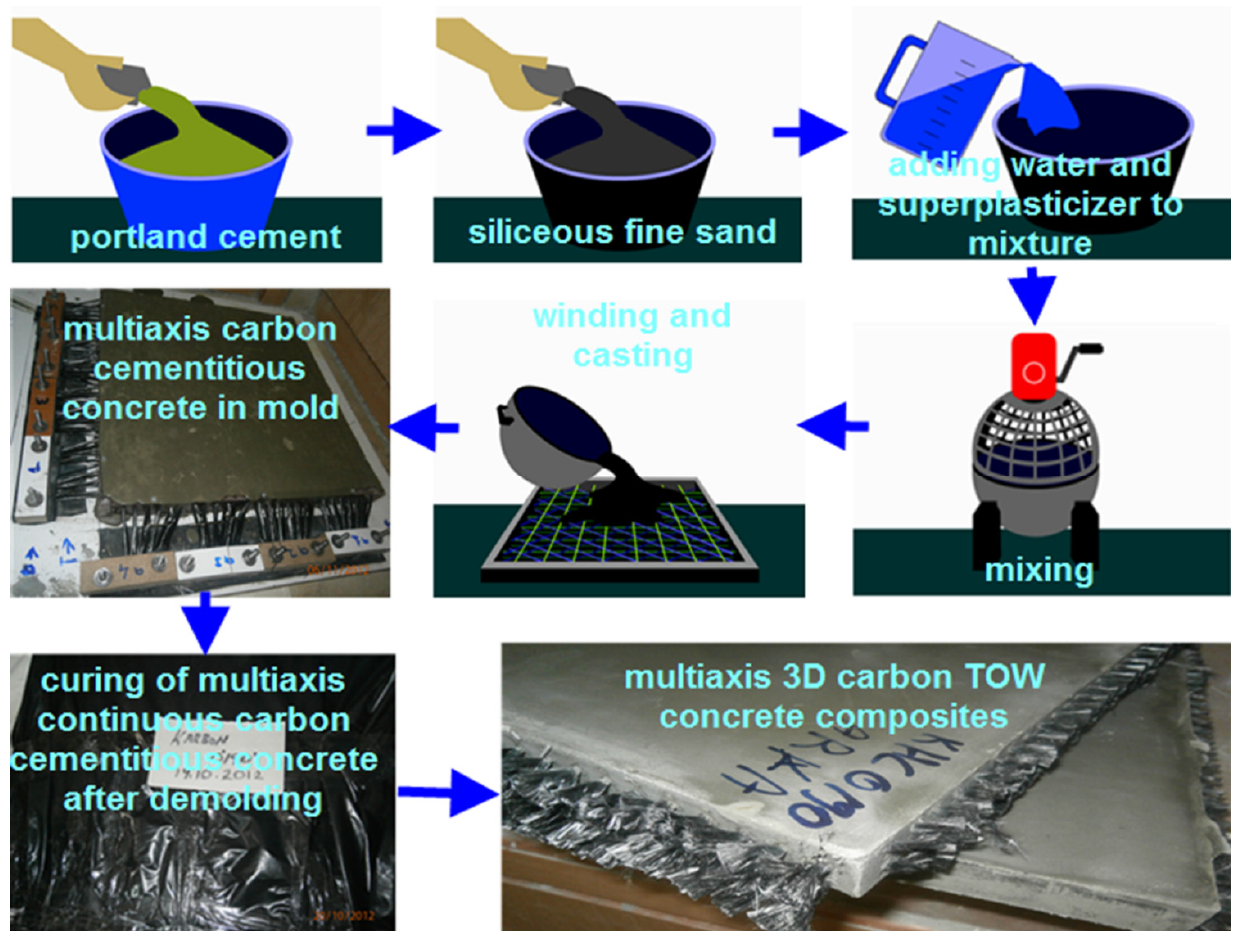
Figure 3. Processing route of multiaxis 3D carbon/cementitious concretes, schematic and actual.